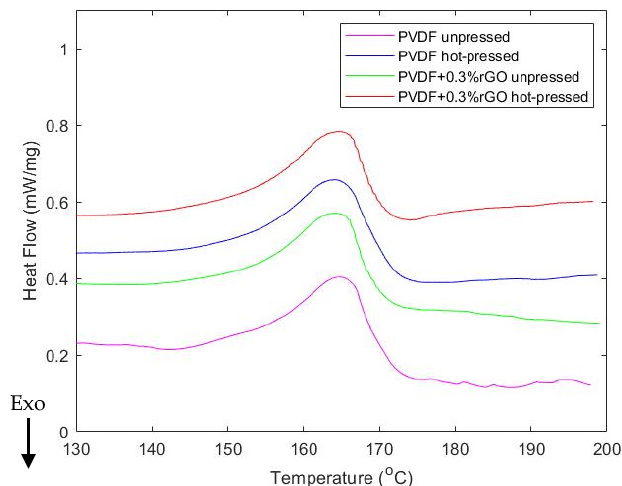
Figure 6. DSC thermogram melting curves. Table 1. Compiled chemical characteristics of the four solution-cast PVDF films.